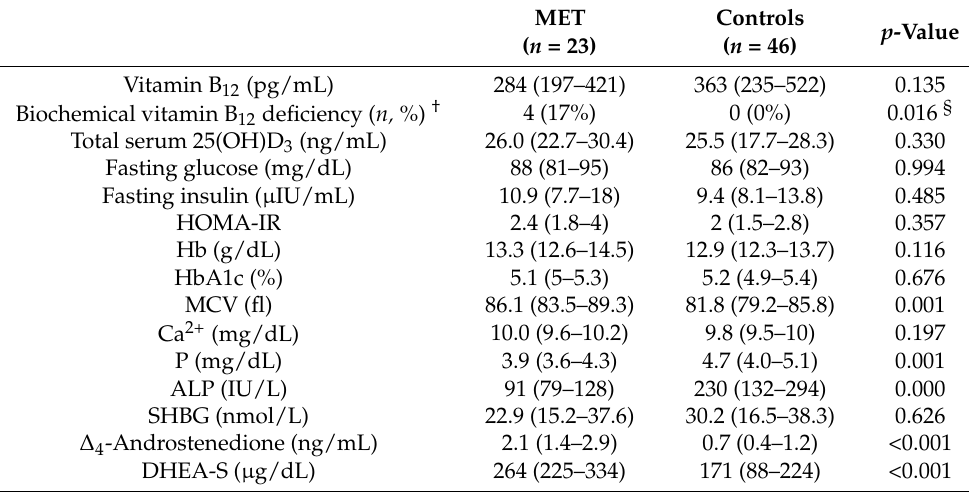
Table 1. Results of the blood assays of participating children in each arm